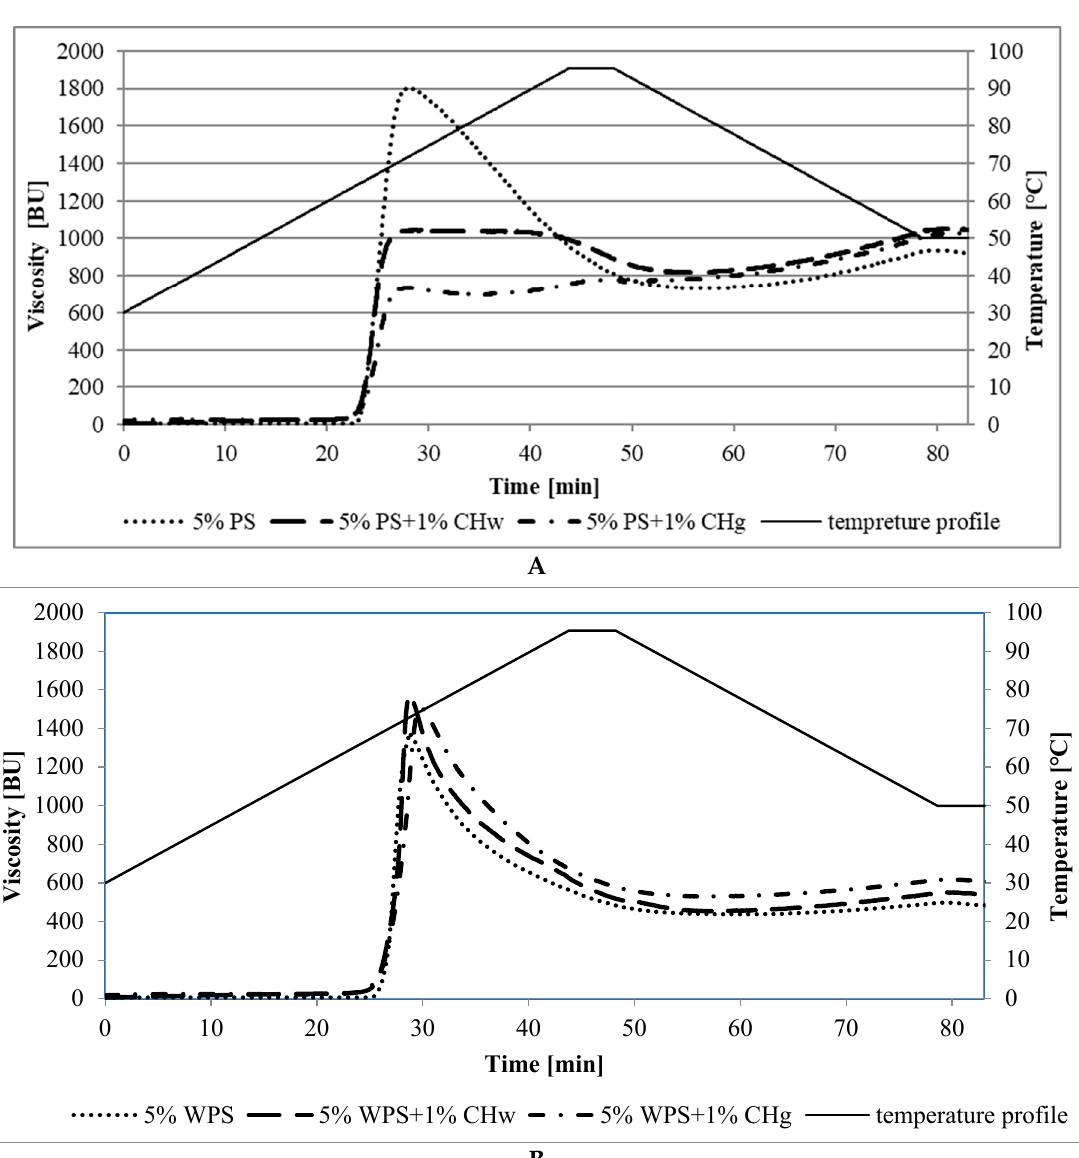
min. (B.U.)—minimum viscosity; BD (B.U.)—breakdown; η 50 0 C (B.U.)—viscosity after cooling to 50 Brabender Units.